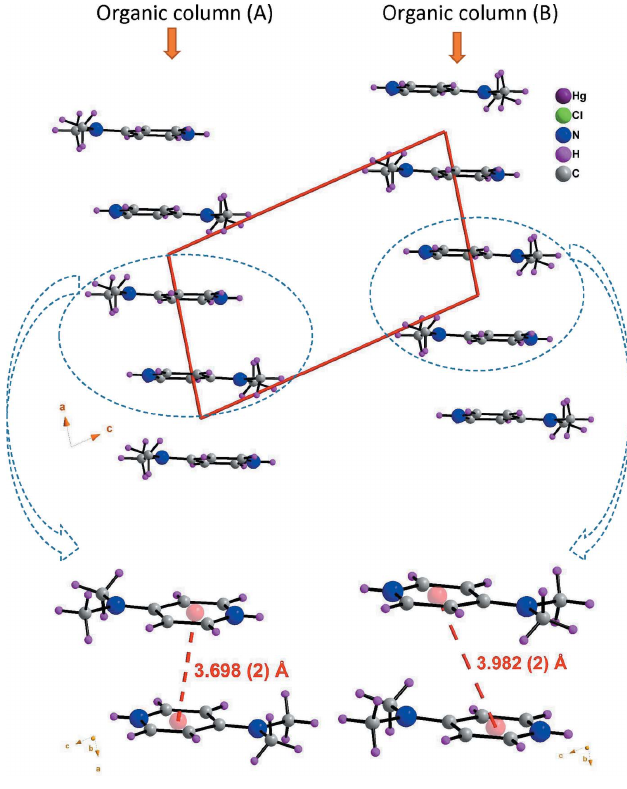
Figure 5 (cid:2) – (cid:2) stacking interactions between the nearest aromatic organic cation neighbors into two types of organic columns ( A or B ).